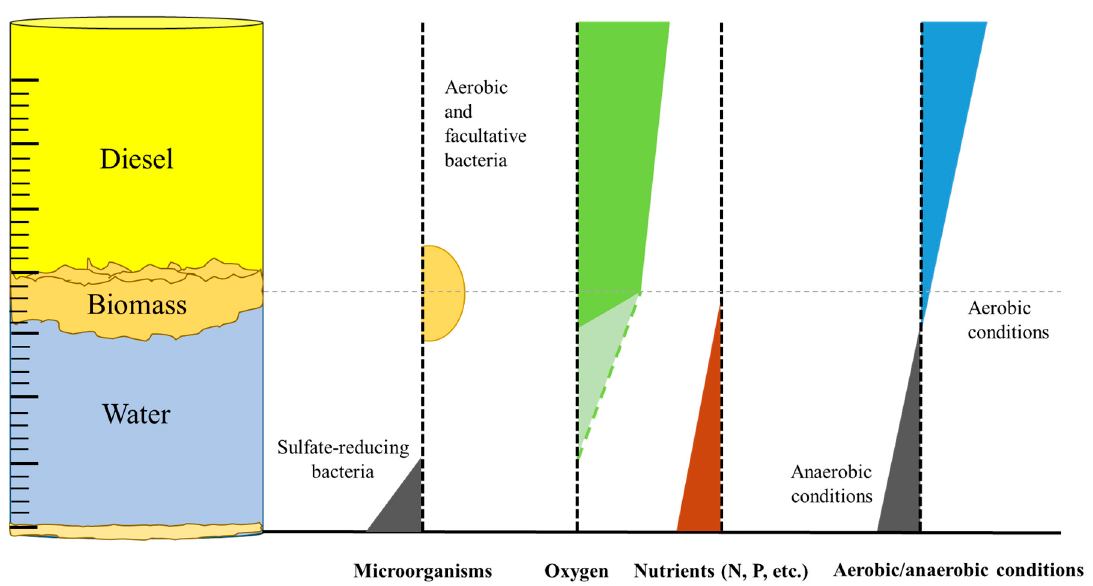
Figure 4. Profiles which represent microbial growth and the concentration of oxygen and nutrients (nitrogen, phosphorous, etc.), as well as the changes of redox potential in an oil/water system. (The dashed line in the oxygen profile represents reduced depletion in cases of immature biofilms and/or limited microbial growth.)